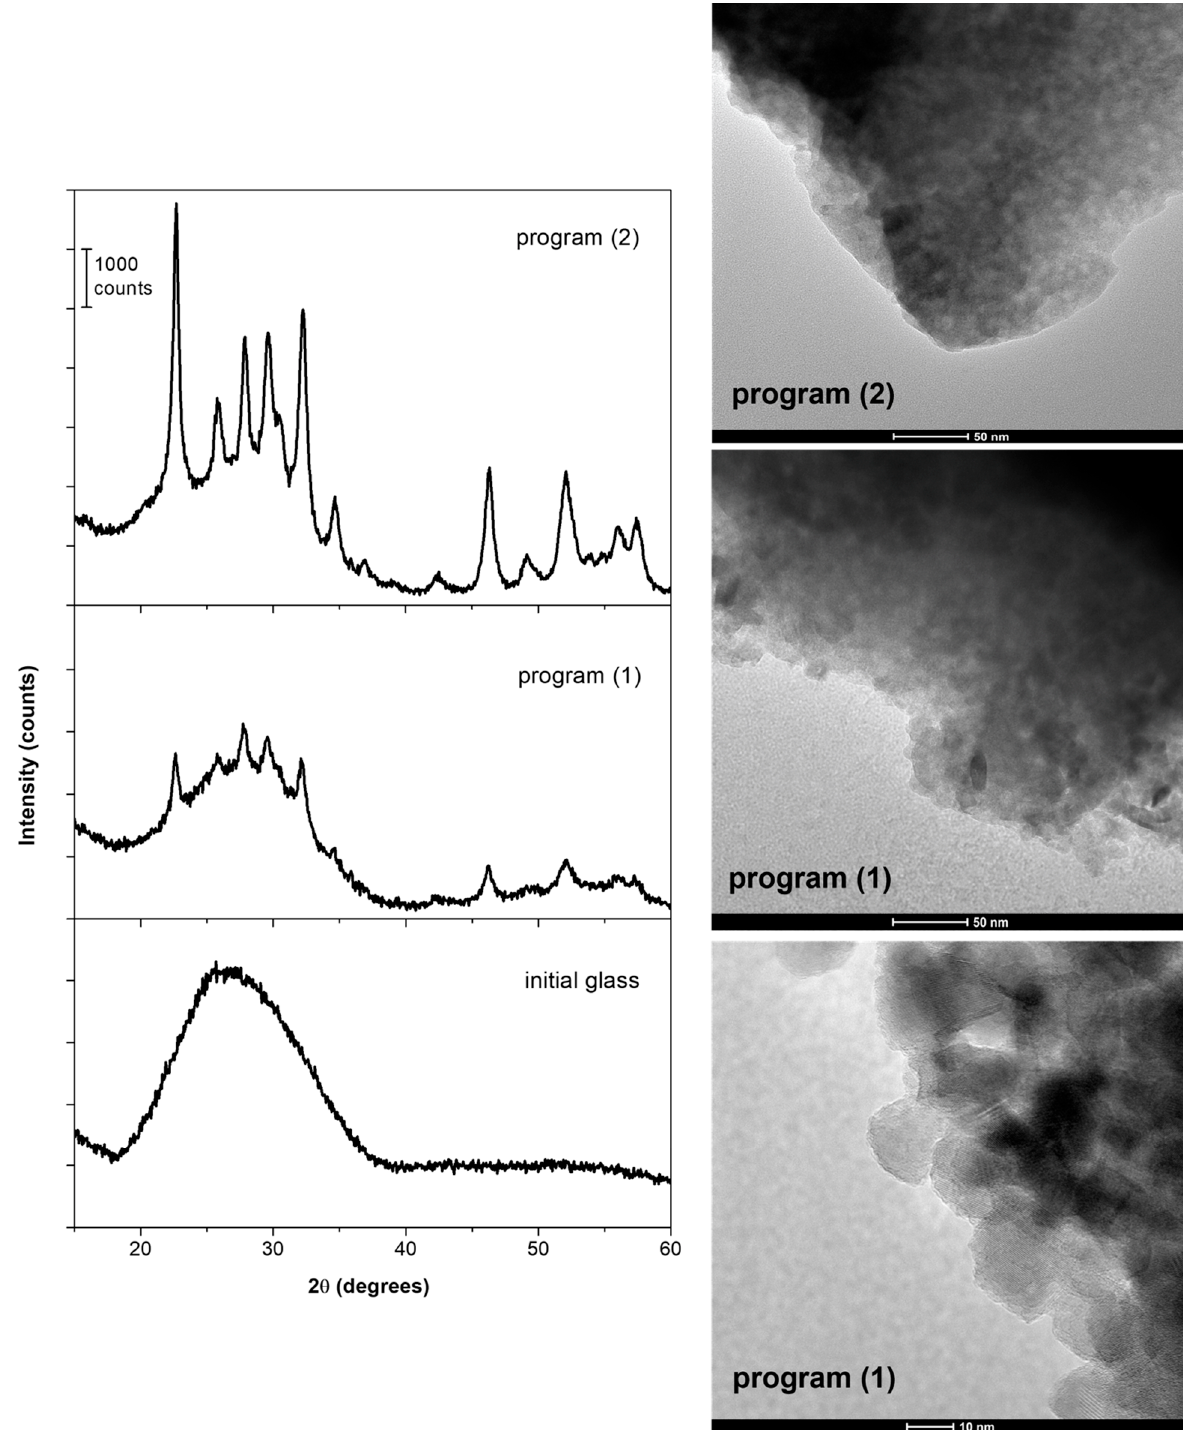
Figure 2. Left column: XRD patterns of initial, nucleated BaNaNS glass subjected to thermal program (1) and to program (2) (from the bottom). Right column: TEM images of nucleated BaNaNS glass subjected to thermal programs 1 and 2.